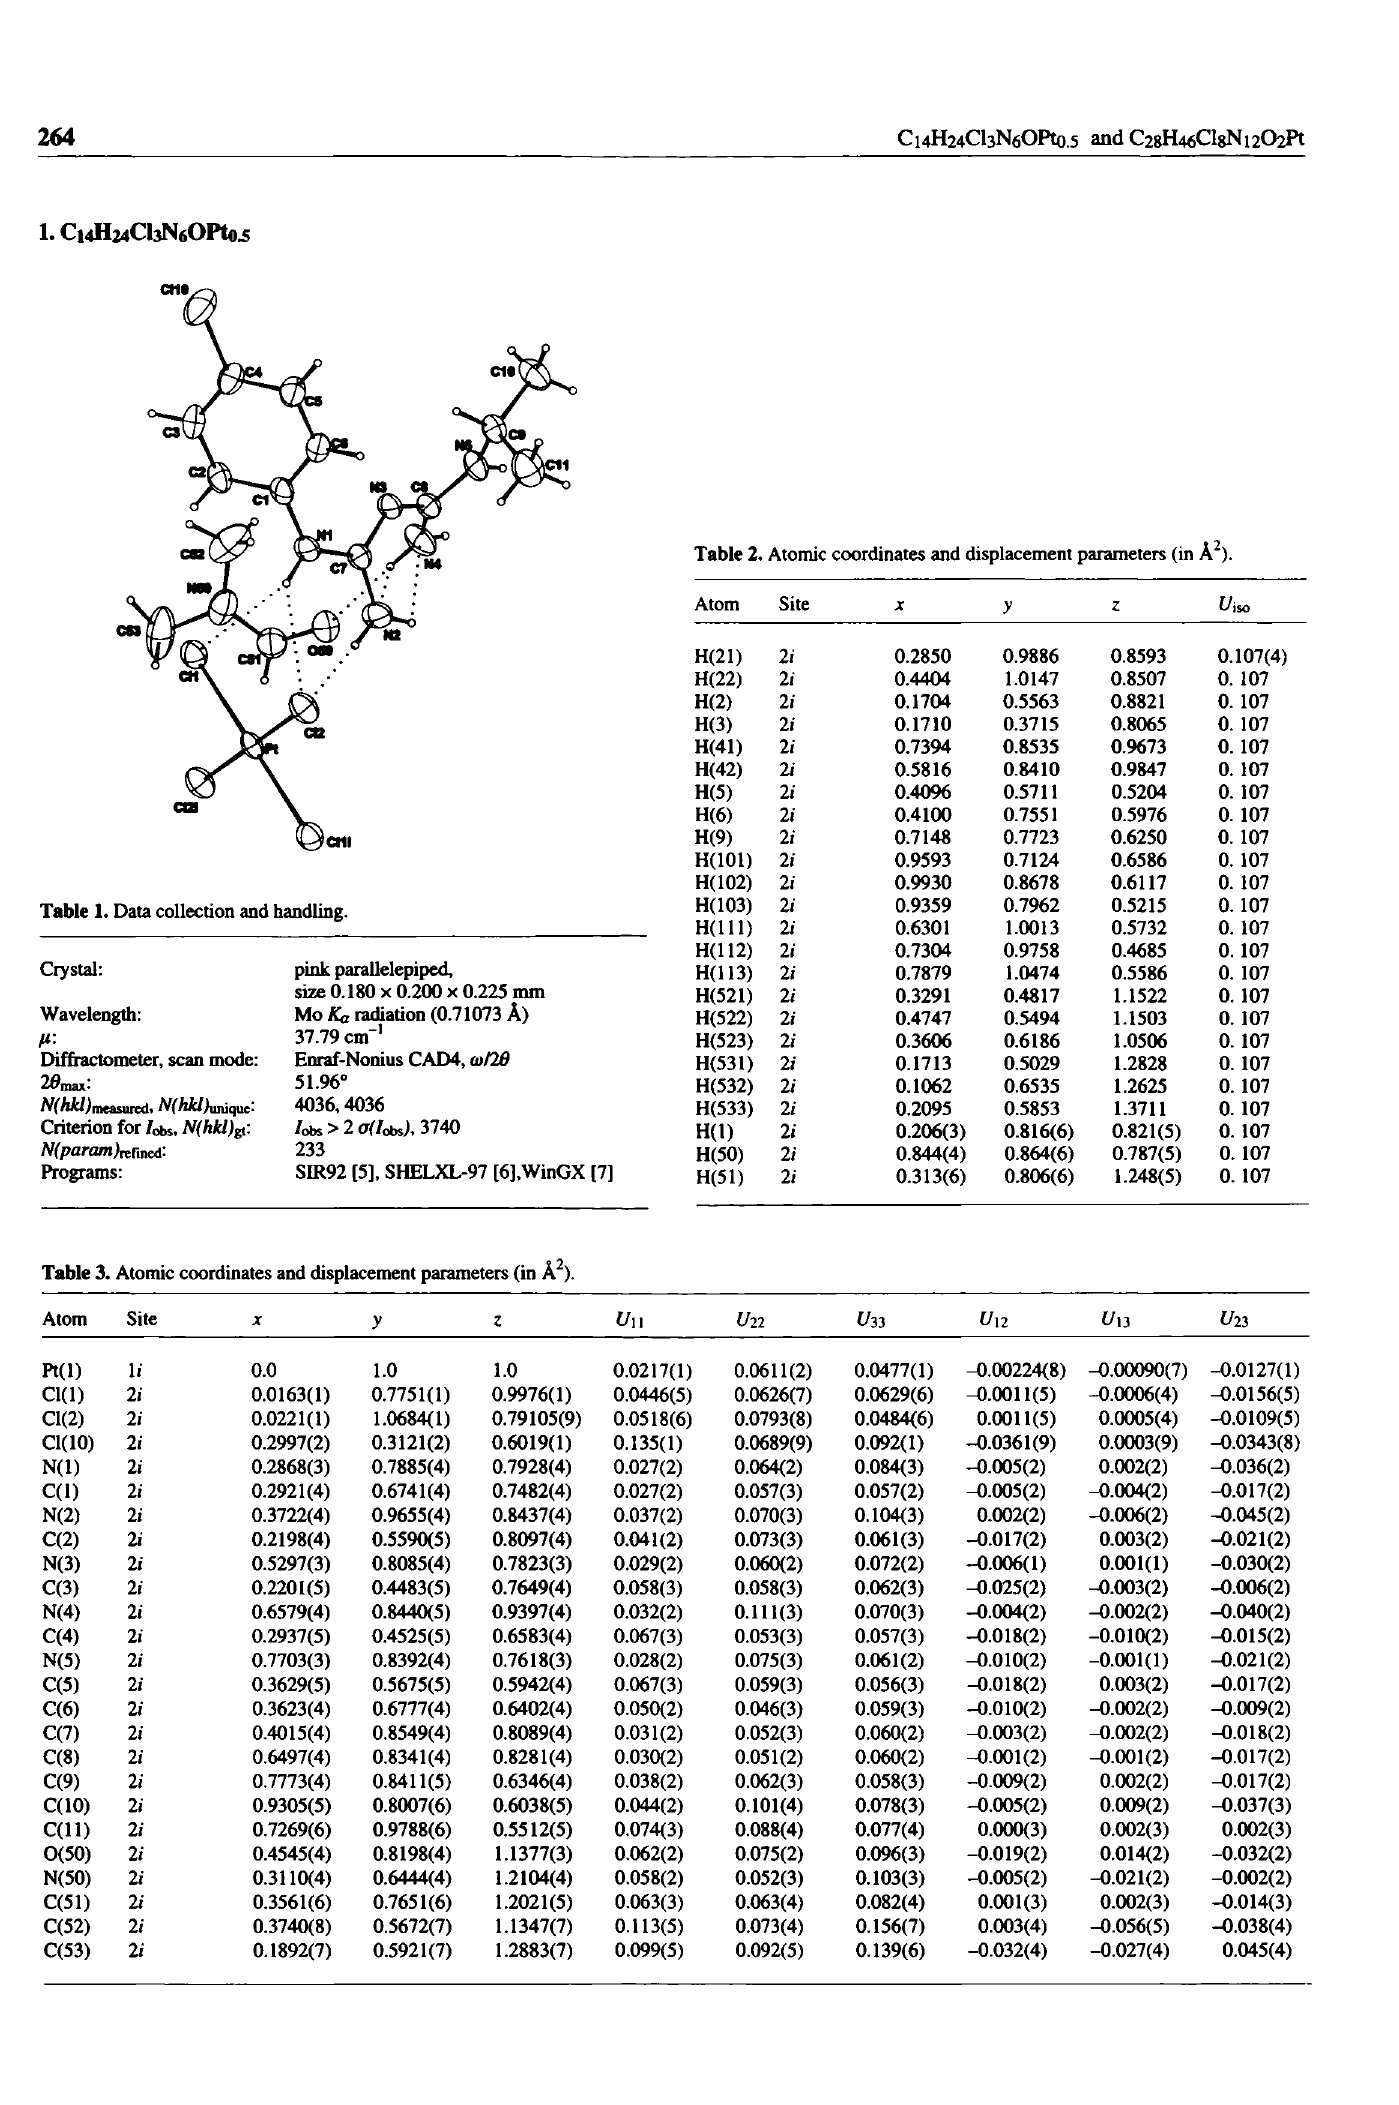
Table 2. Atomic coordinates and displacement parameters (in Â 2